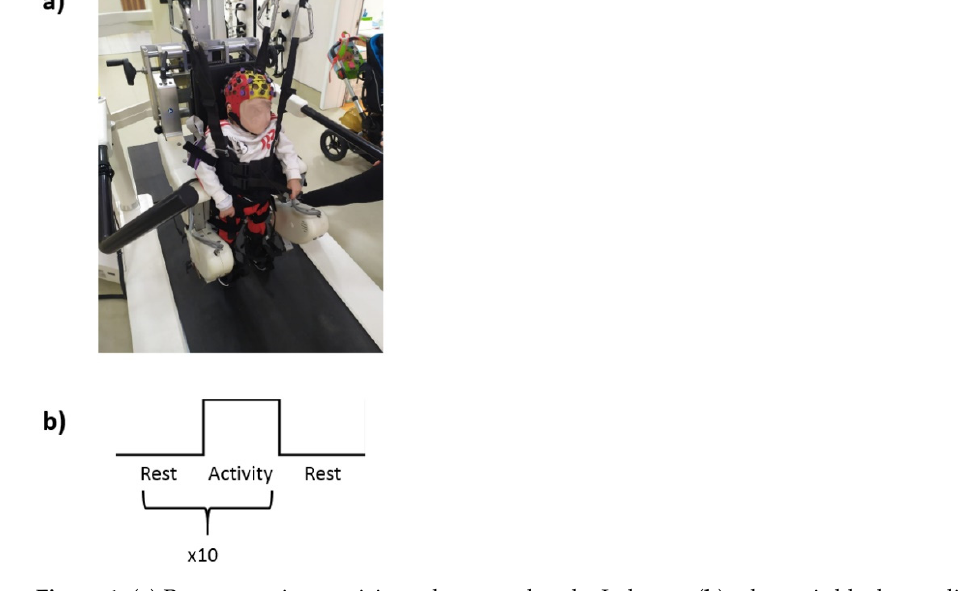
Figure 1. ( a ) Representative participant harnessed to the Lokomat ( b ) schematic block paradigm of the experiment.